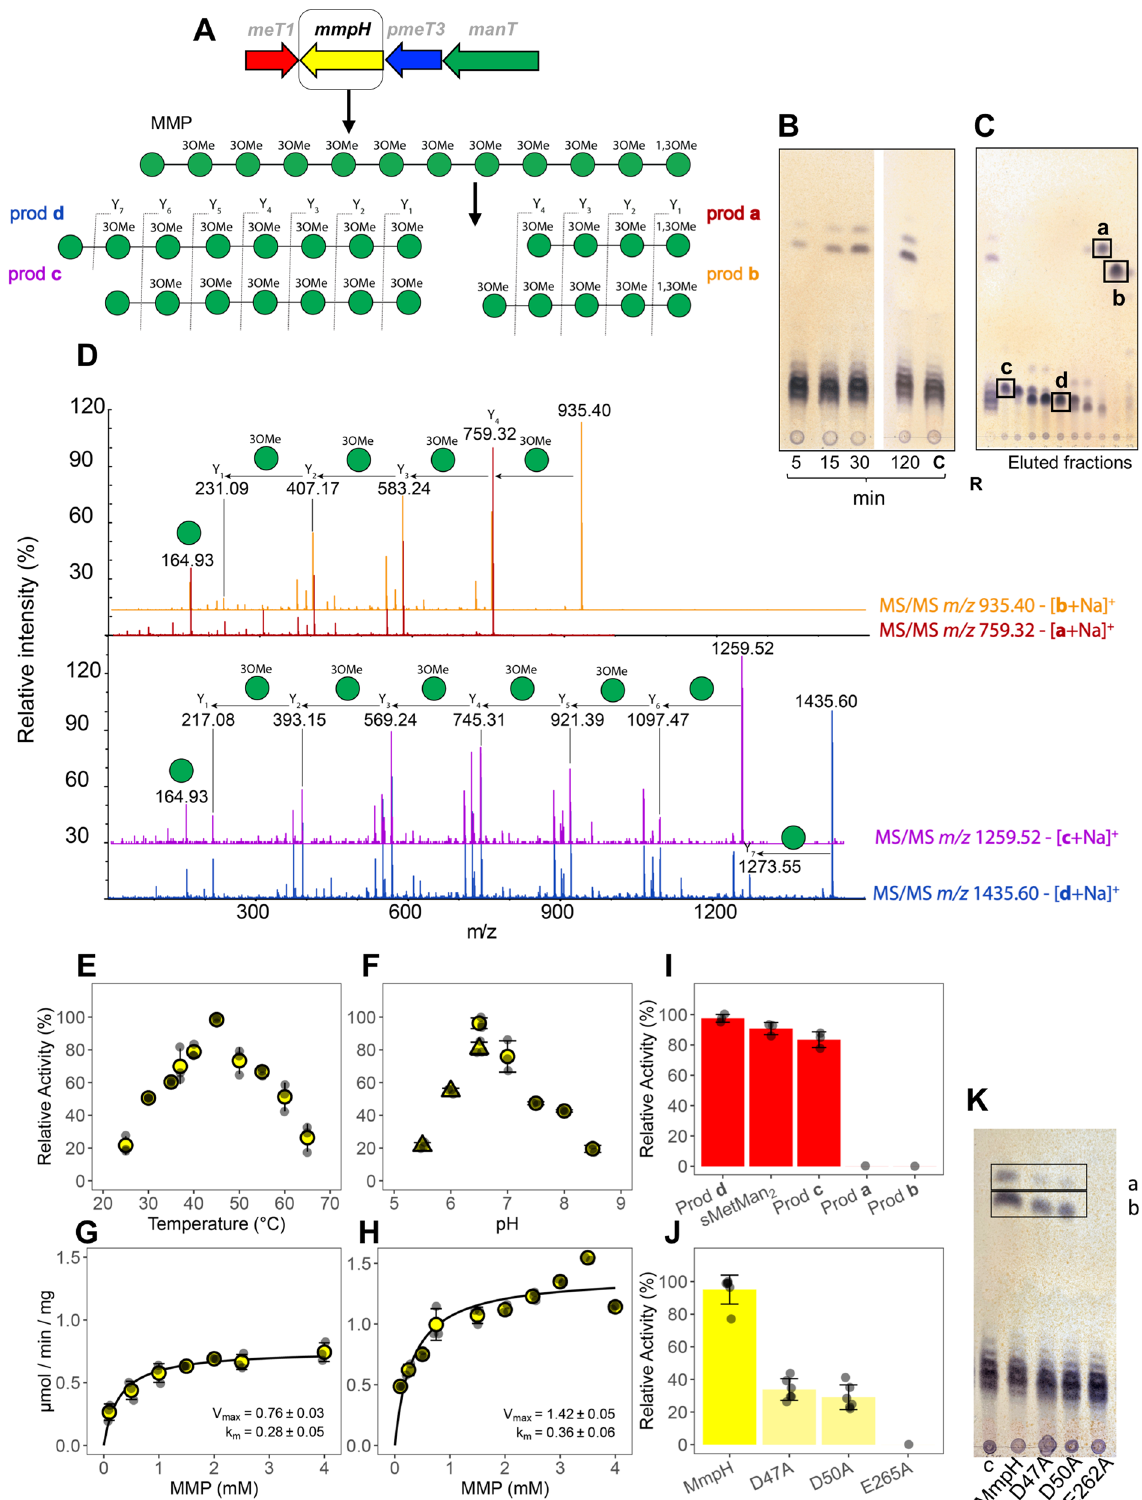
perfringens (PDB entry 3QT9 29 , Z-score = 24.9, r.m.s.d. = 3.6 Å, 10% amino acid sequence identity). Family GH125 is a relatively large and widespread group of enzymes frequently found in bacterial pathogens, bacterial human gut symbionts, and a variety of fungi 29 . Despite the low amino acid sequence identity between GH125 and GH15 family members, shared structural aspects of their catalytic centers suggest that family GH125 belongs to the GH-L glycoside